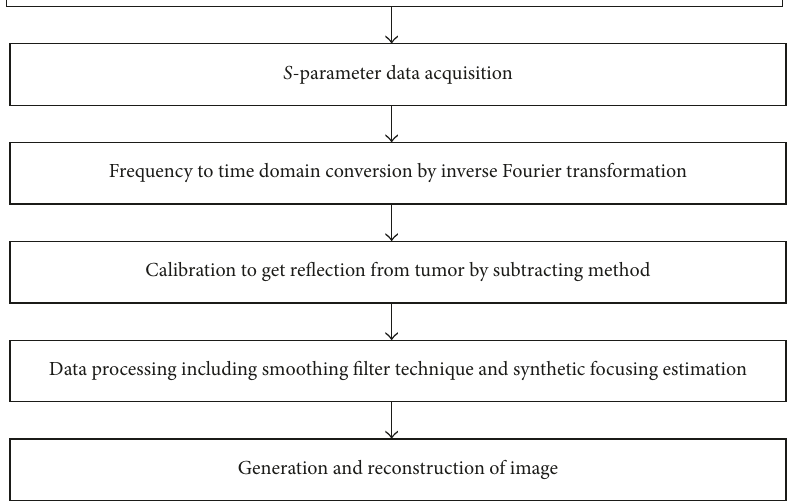
Figure 2: Confocal microwave image reconstruction algorithm for the considered brain imaging system model.